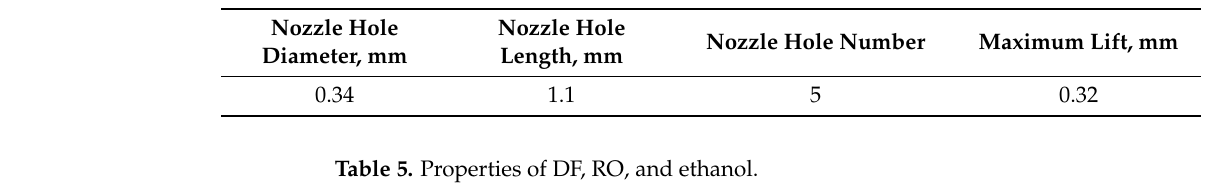
Table 4. Injector nozzle specifics.